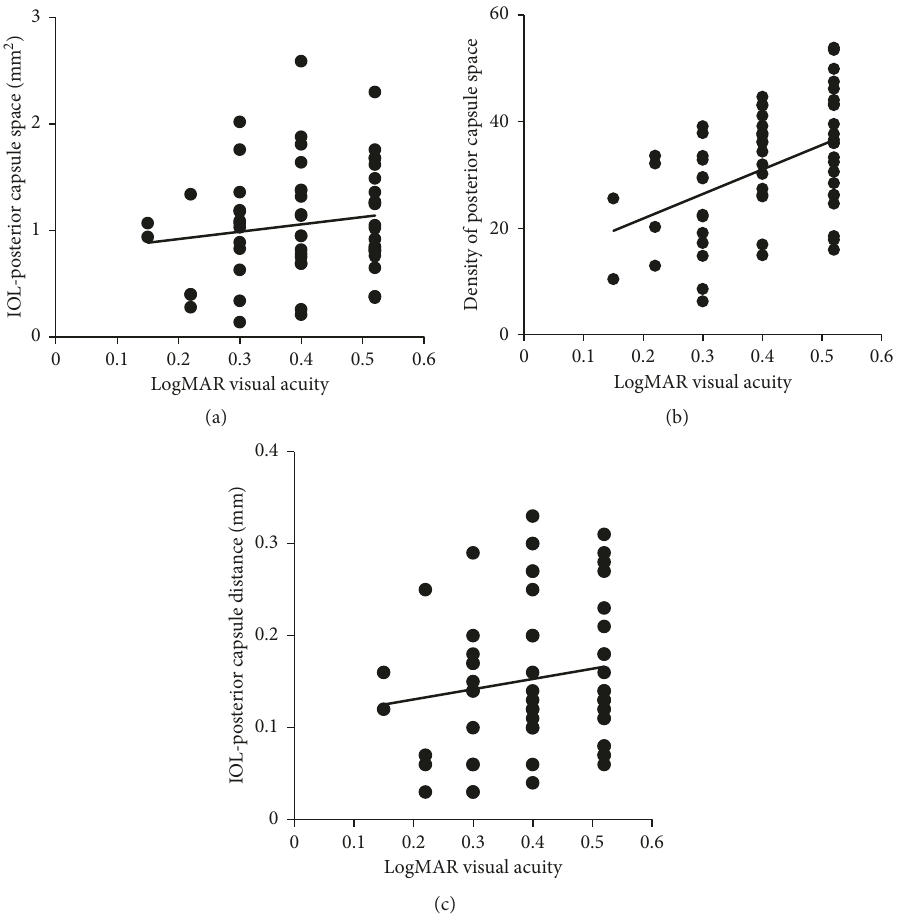
Figure 4: Correlation analysis between visual acuity and IOL-posterior capsule space. (a) Correlation between visual acuity and the area of the IOL-posterior capsule space using RTVue-100 OCT. Spearman’s correlation analysis reported that the correlation coefficient was 0.11 ( p � 0 . 42). (b) Correlation between visual acuity and the density of the IOL-posterior capsular space. The correlation coefficient was 0.42 ( p ≤ 0 . 001). (c) Correlation between visual acuity and the IOL-posterior capsular distance. The correlation coefficient was 0.14 ( p � 0 .